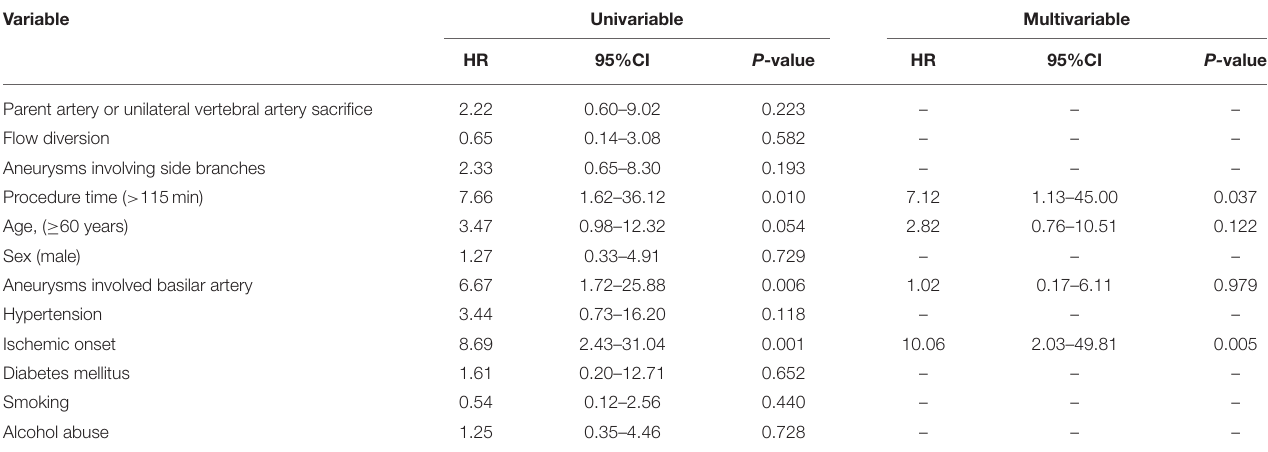
TABLE 4 | The univariate and multivariate Cox regression analysis for serious adverse events.